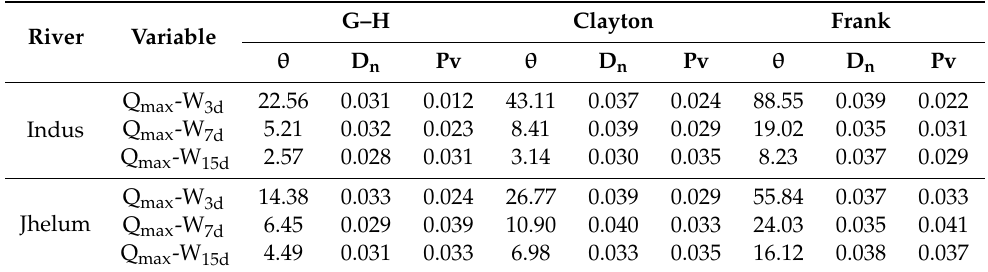
Table 4. Parameters of copulas and values of statistical test for determining suitable